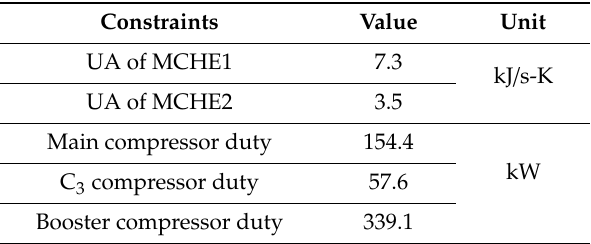
Table A3. Additional constraints for propane pre-cooled